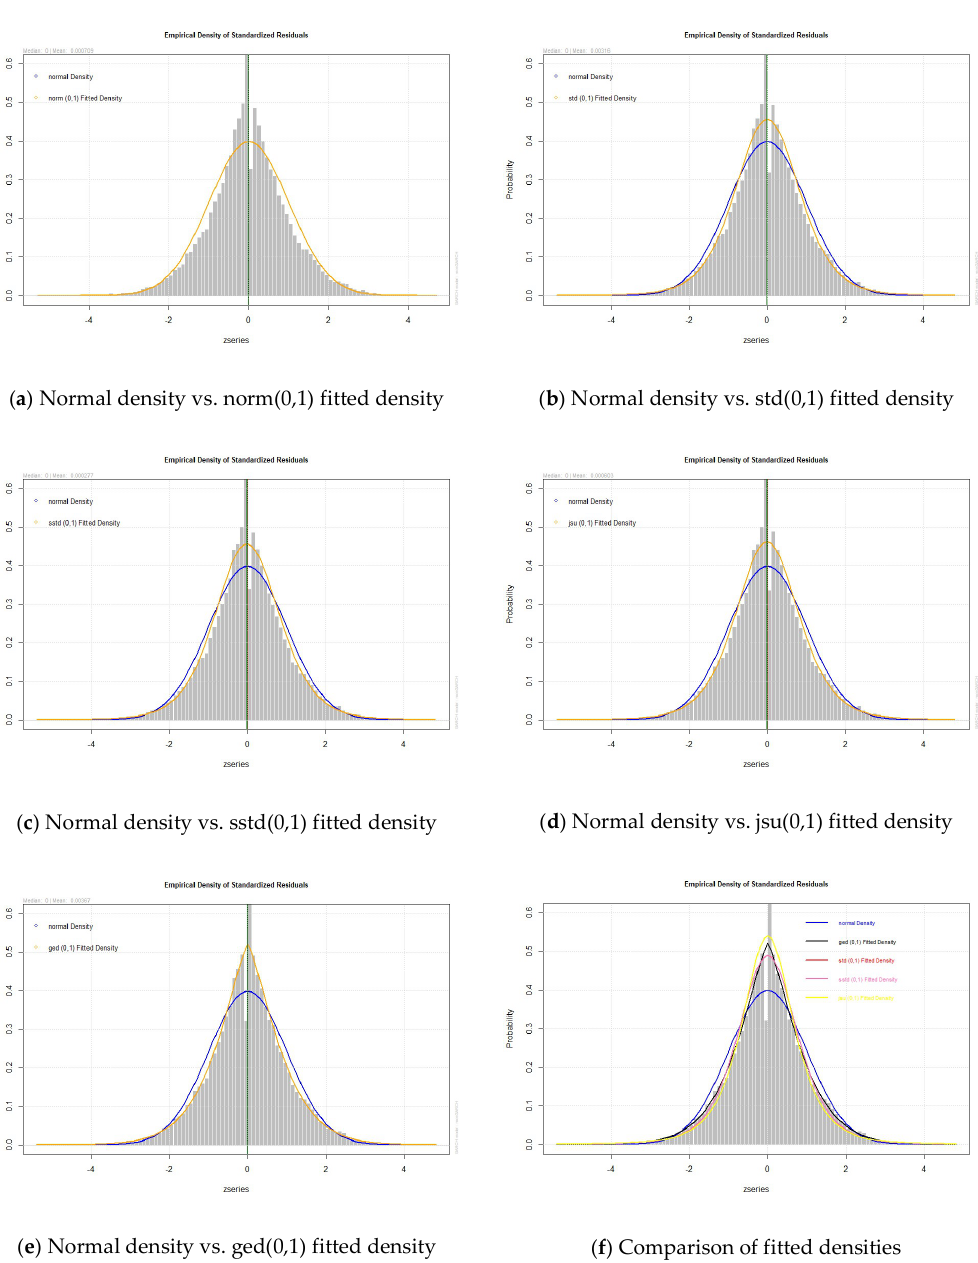
Figure 5. Empirical density of the standardised residuals.